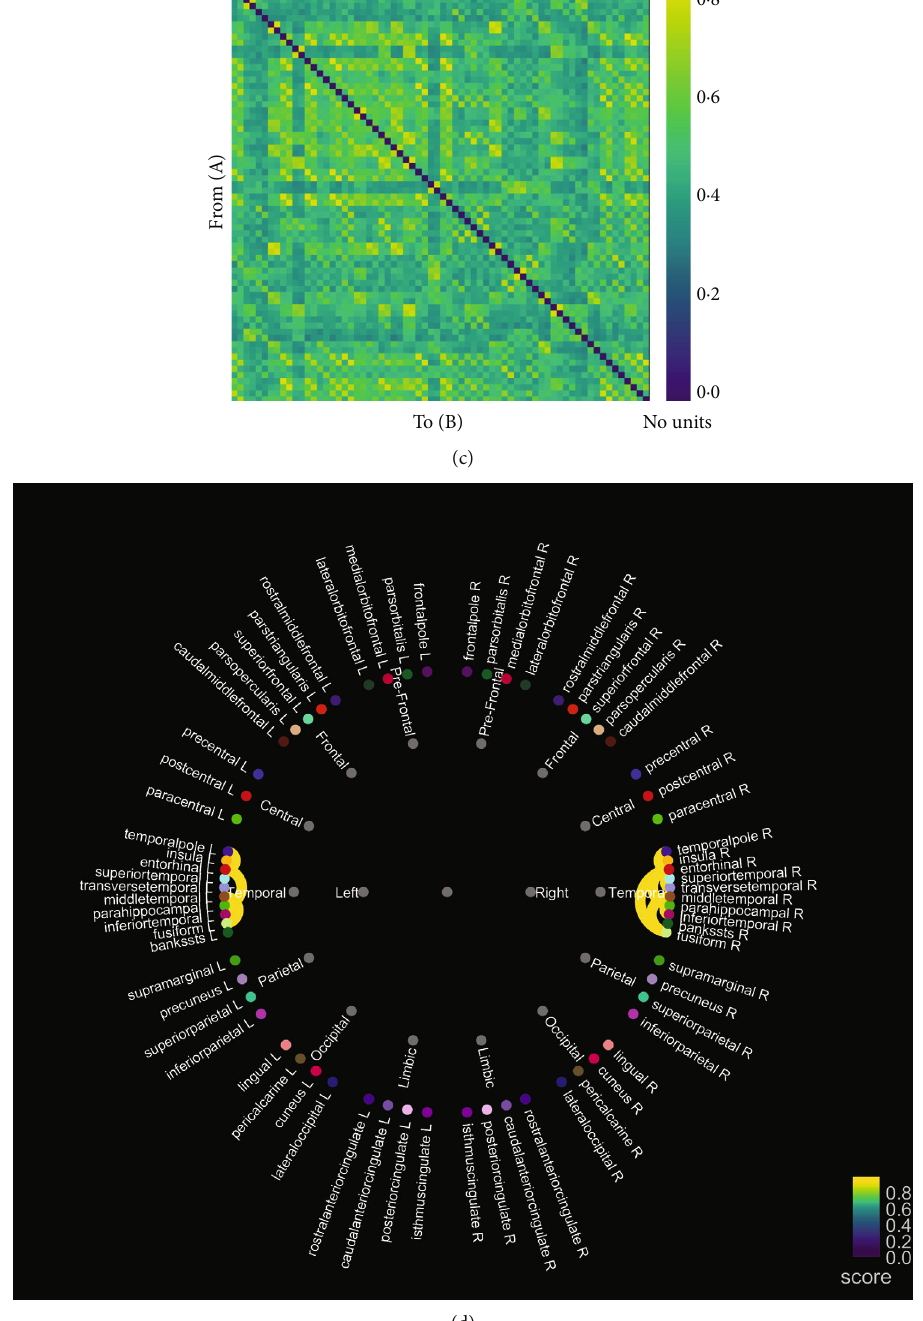
Figure 4: The Pearson r matrix diagram and circos diagram. (a, b) CG group connection matrix diagram. It can be seen that the Pearson r is higher in each brain region and between hemispheres. (c, d) In the DOC group, only a few connections were found in the temporal lobe and no obvious connection between hemispheres. (DOC: disorder of consciousness; CG: control